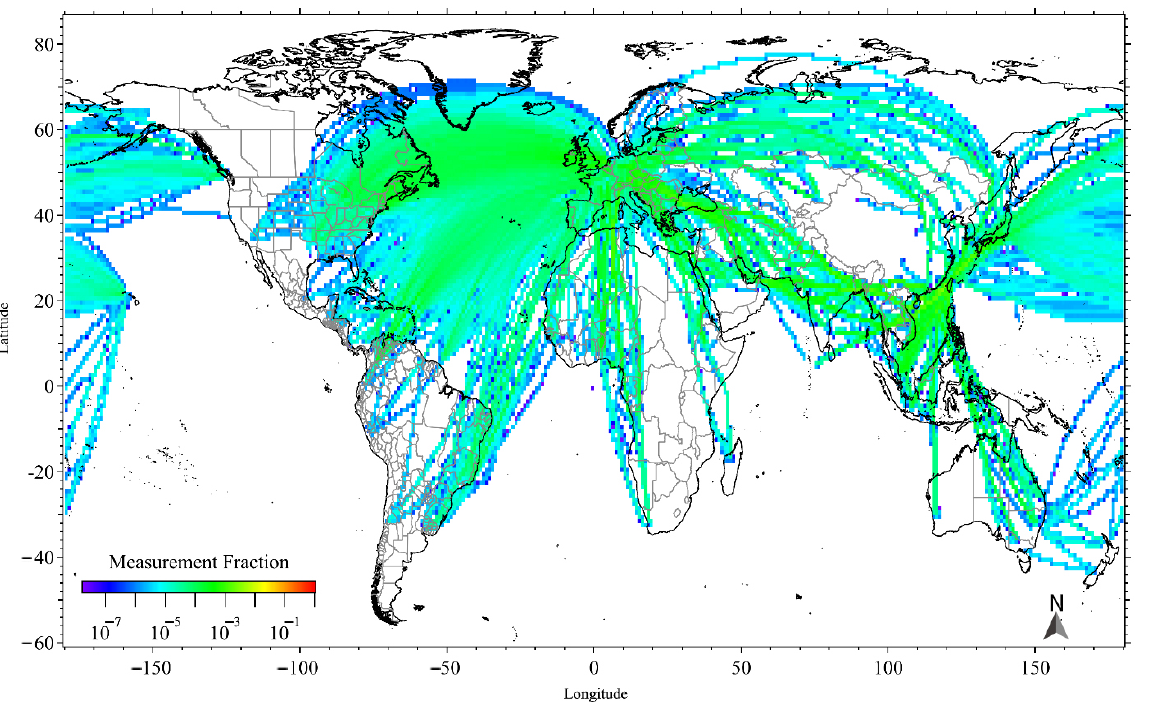
Figure 2. Global measurement fraction from the backscatter cloud probe on the IAGOS fleet of Airbus aircraft.